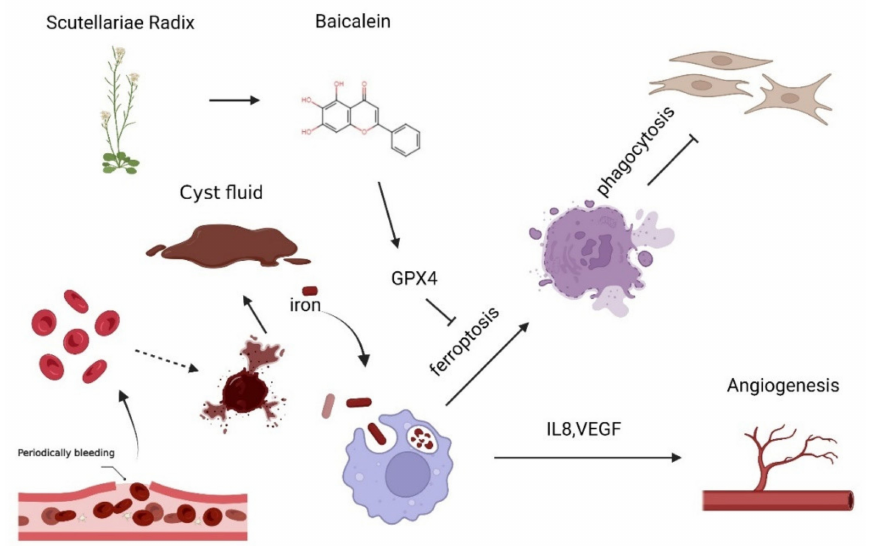
Figure 7. Baicalein restores ferroptosis-induced phagocytosis inhibition of macrophage in endometrio- sis. A high iron environment leads to ferroptosis of macrophages in ovarian endometriosis. Fer- roptosis reduced phagocytosis in macrophages, thus leading to loss of ability to clear the ectopic endometrium. Additionally, the up-regulation of angiogenic factors VEGFA and IL8 in macrophages in ferroptosis may contribute to angiogenesis in EMs. As a natural flavonoid compound extracted from scutellariae radix, baicalein effectively restores the reduced phagocytosis in macrophages induced by ferroptosis partly by increased GPX4